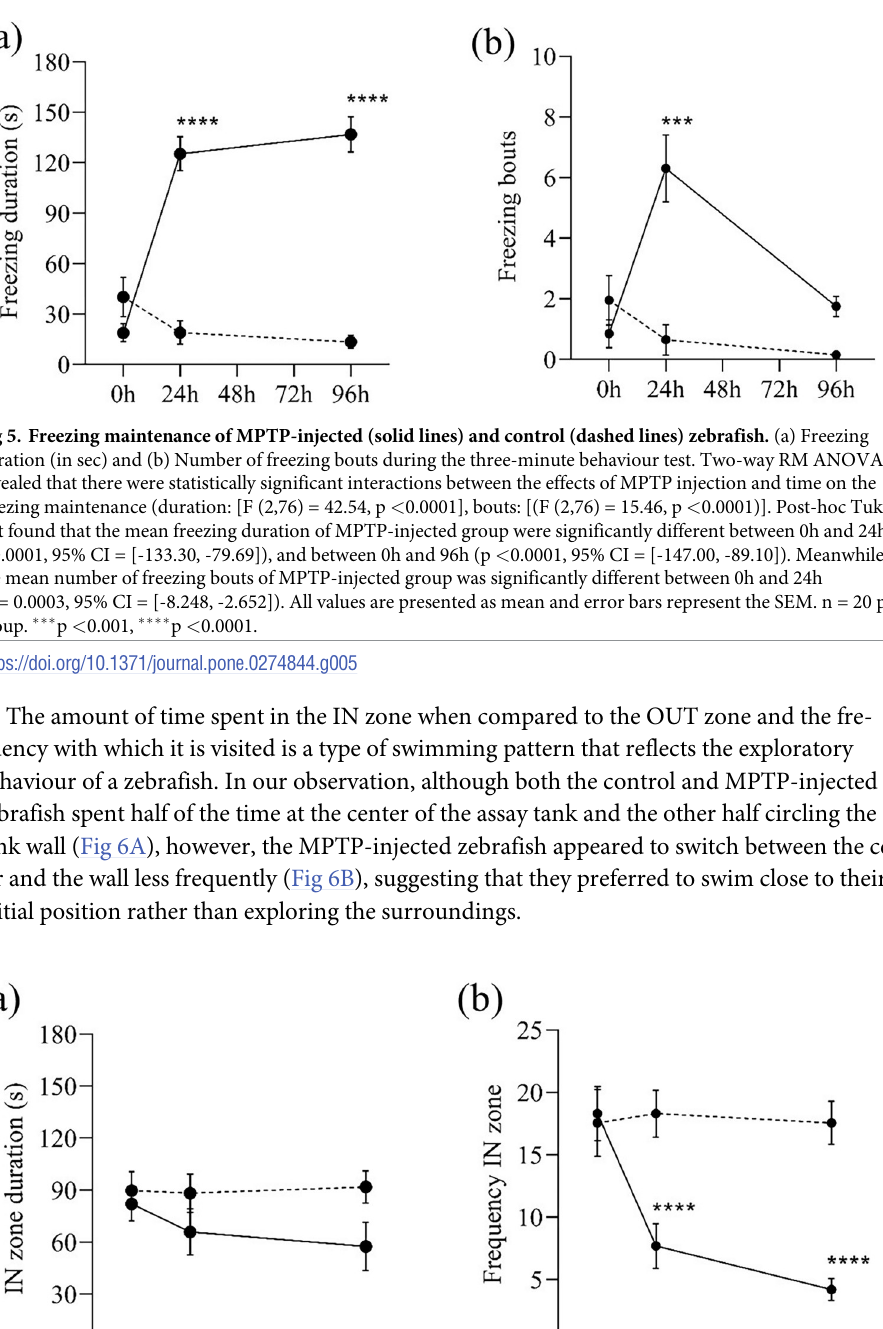
Fig 6. IN zone position of MPTP-injected (solid lines) and control (dashed lines) zebrafish (a) IN zone duration (in sec) and (b) Frequency in the IN zone during the three-minute behaviour test. Two-way RM ANOVA revealed that there was no statistically significant interaction between the effects of MPTP injection and time on the time spent in IN zone (F (2,76) = 0.85, p = 0.423). However, there was a significant interaction between the effects of MPTP injection and time on the frequency in IN zone (F (2,76) = 8.55, p = 0.0004). Post-hoc Tukey’s test found that the mean frequency in IN zone of MPTP-injected group were significantly different between 0h and 24h (p < 0.0001, 95% CI = [5.889, 15.31]), and between 0h and 96h (p < 0.0001, 95% CI = [7.974, 20.23]). All values are presented as mean and error bars represent the SEM. n = 20 per group. ���� p < 0.0001.